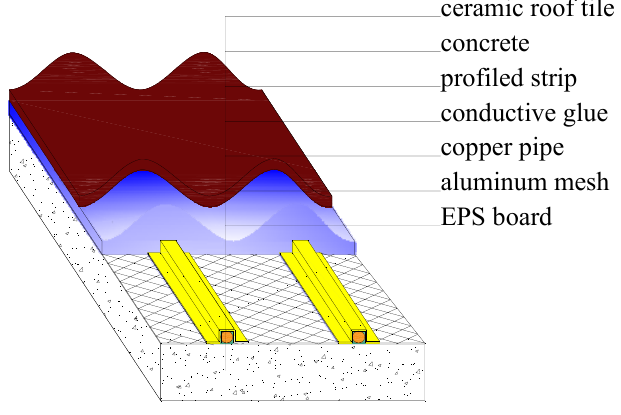
Figure 4. The arrangement of the solar collector.